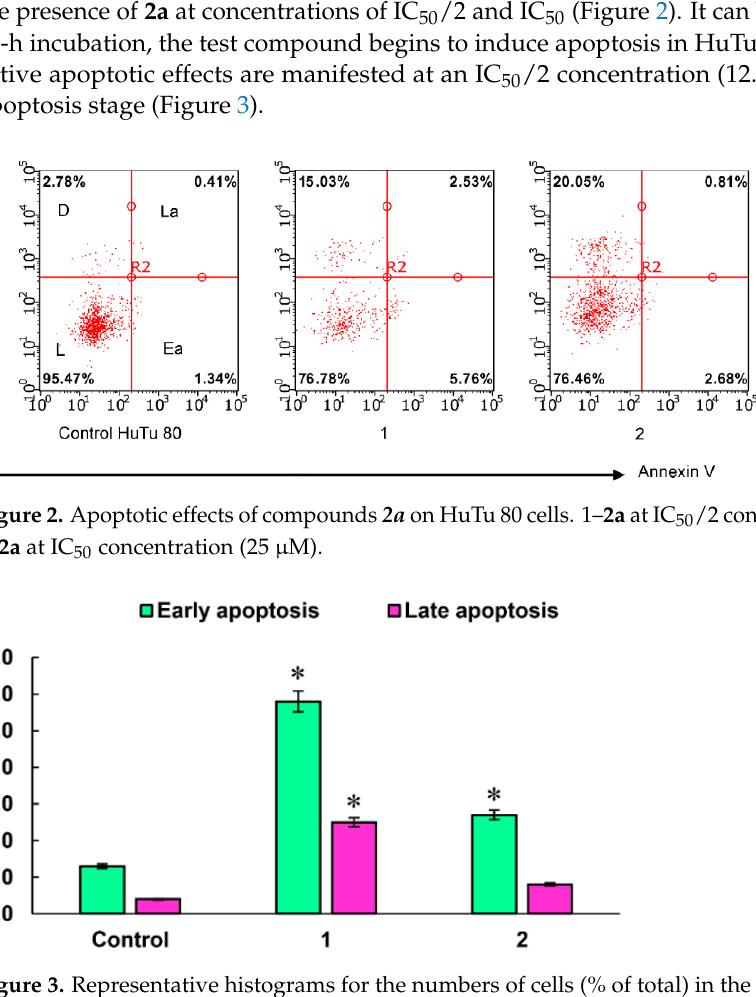
Figure 1. Effect of compound 2а on cell cycle of HuTu 80 by flow cytometry. 1 – 2а at IC 50 /2 concen- tration (12.5 µM); 2 – 2а at IC 50 concentration (25 µM).